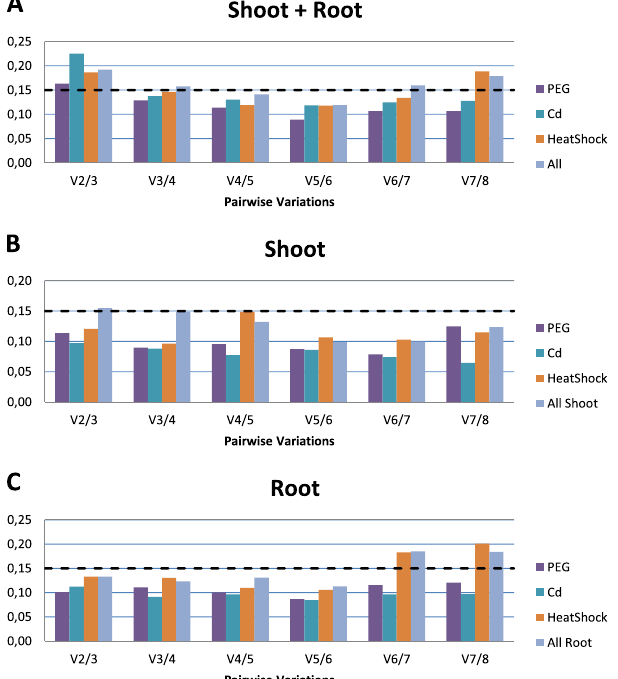
Figure 2. Determination of best reference gene number calculated by geNorm pairwise variation (Vn/Vn + 1) under independent stress treatment and their combination in both shoot and root together ( A ), shoot ( B ), and root ( C